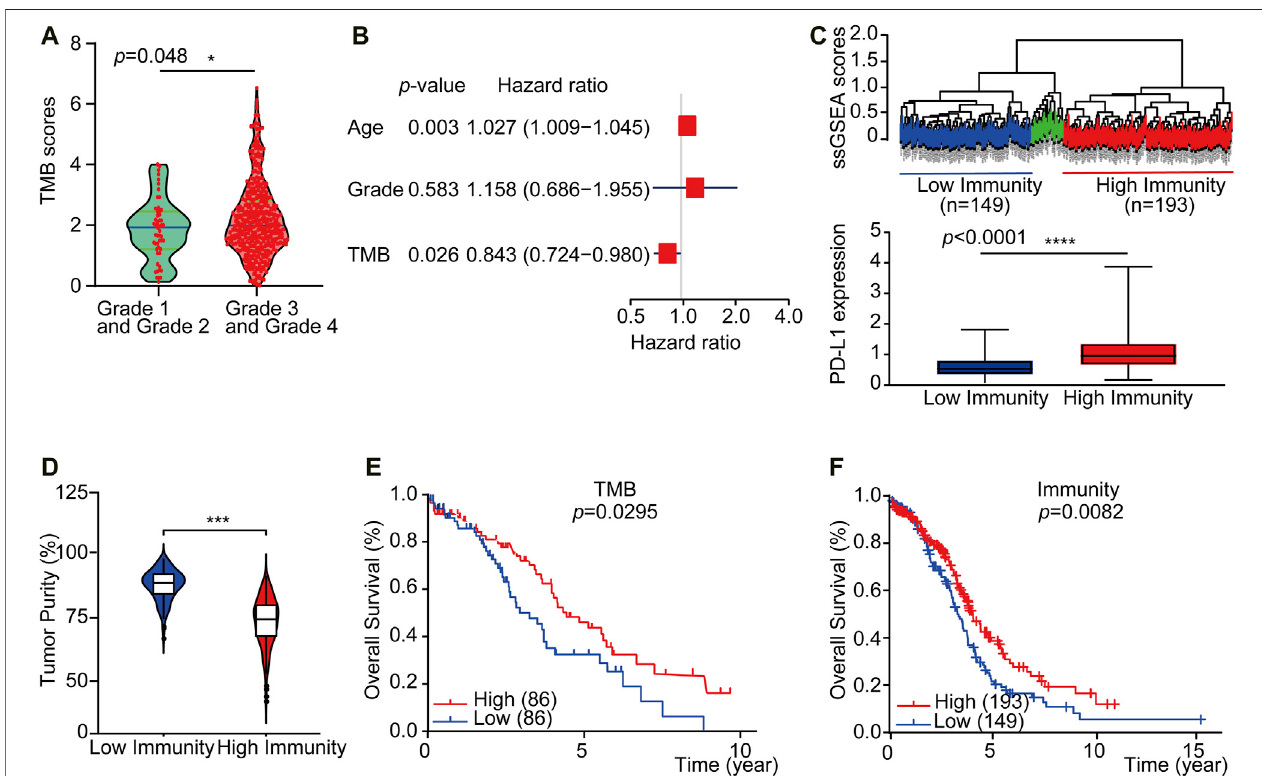
FIGURE 2 | TMB high group and immunity high group have a better overall survival of OC. (A) The violin plots showed the interrelationship between TMB scores and OCgrades( n (cid:1) 417,exceptfortheblankvalues, p (cid:1) 0.0480). (B) MultivariateCoxregressionanalysisanalyzesTMBandOCpatientclinicalfactors. (C) Up:Unsupervised clustering ofOCpatientsfrom the TCGA cohort using ssGSEA scores from immune celltypes. Hierarchical clustering wasperformed withEuclideandistanceand Ward linkage.Threedistinctimmunein fi ltrationclusters,herewede fi nedimmunity low group(blue)andimmunity high group(red),respectively.Down:Boxplotshowedthat PD-L1 expression wassigni fi cantlyhigher inimmunity high group (As displayed byMann-Whitney test, p < 0.0001). (D) Theviolinbox plot showed that thetumor purity in immunity high groupissigni fi cantlylower(log-ranktest, p < 0.05). (E) OCpatientswereclassi fi edintotwogroupsbasedonTMBscores:thesampleswithTMB high scores in the top 20% and the TMB low samples with TMB scores in the bottom 20%of all OCsamples. According to the Kaplan-Meier survival curve, the overall survival time of TMB high group is longer than TMB low group (2.58 vs. 1.92 years, n (cid:1) 430, except for the blank values, as displayed by the long-rank test, p (cid:1) 0.0295). (F) OC patients were classi fi ed into two groups based on ssGSEA scores: those with immunity high group in 193 patients and those with immunity low group in 149 patients. The overall survival time of immunity high group is longer than immunity low group (2.77 vs. 2.67 years, n (cid:1) 364, except for the blank values, as displayed by the log-rank test, p (cid:1)